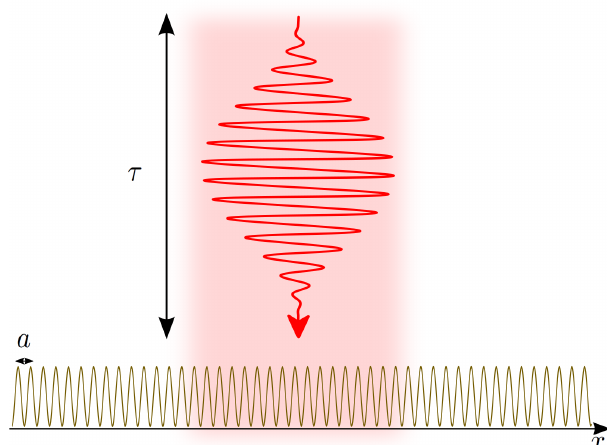
Figure 1. Schematic view of an external laser-driven periodic structure. The duration of the pulse is denoted by τ and the lattice constant of the 1D crystal is given by a . Note that, usually, the central wavelength of the incoming laser pulse is larger than a , meaning that dipole approximation can be used.